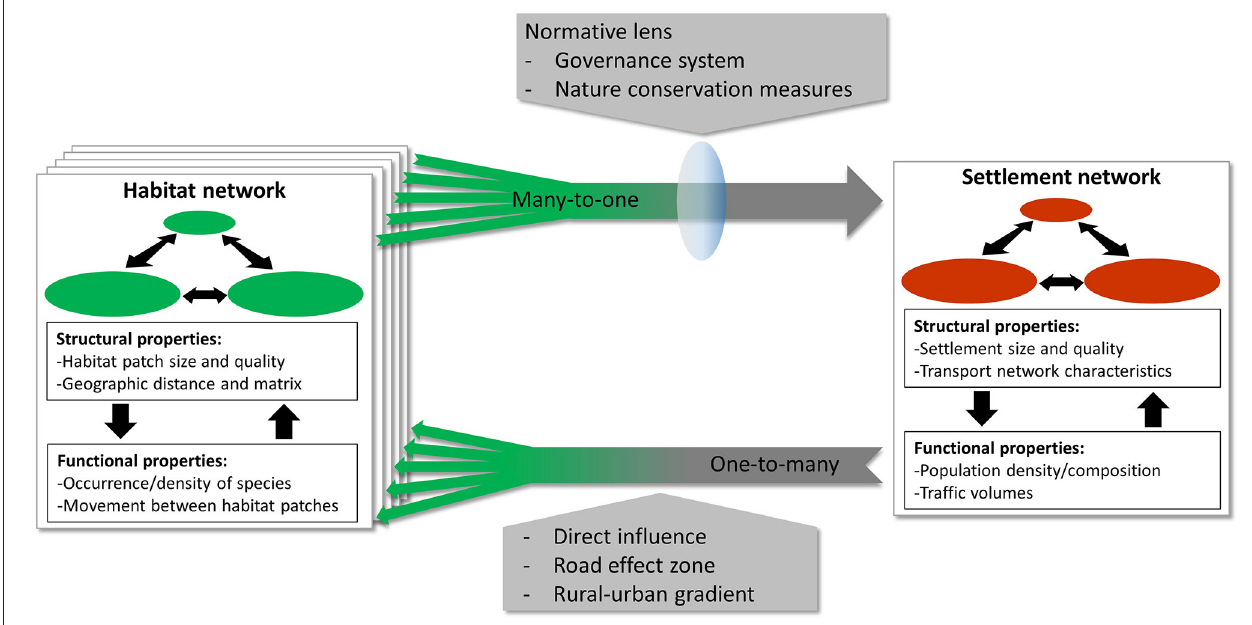
FIGURE 1 | Conceptual framework of models of coupled settlement and habitat networks. The different interactions and influences within and between settlement and habitat networks are shown. Both types of network are embedded in the same landscape. In general there is one settlement network and multiple species-specific habitat networks. Changes in the settlement network often influence several habitat networks (i.e., one-to-many relationship), whereas habitat networks usually only influence the settlement network if change takes place in multiple networks (i.e., many-to-one relationship). Network-internal interactions are between structural and functional properties of the networks. Changes to the structural or functional properties of settlement network can have a direct influence on habitat networks, but also an indirect influence via a range of effects that radiate out from roads (i.e., road-effect zone) or from settlement centers (i.e., urban-rural gradient). The influence of the habitat networks on the settlement network is rarely direct, but usually only arises once nature conservation measures are installed, which are a result of the implemented governance system and influenced by the normative lens through which society views biodiversity and its